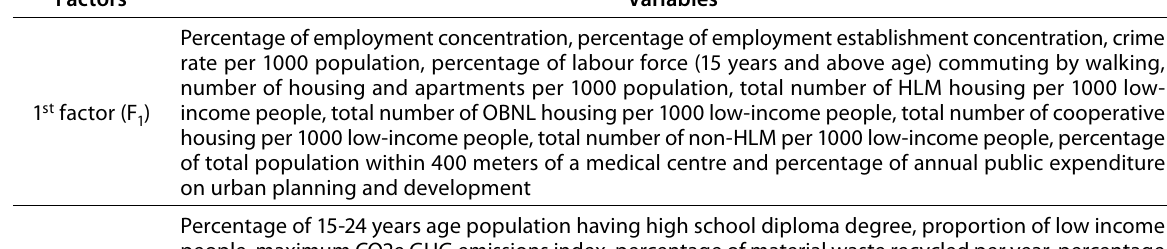
Table 2. Extracted variables within the four groups of factors Factors